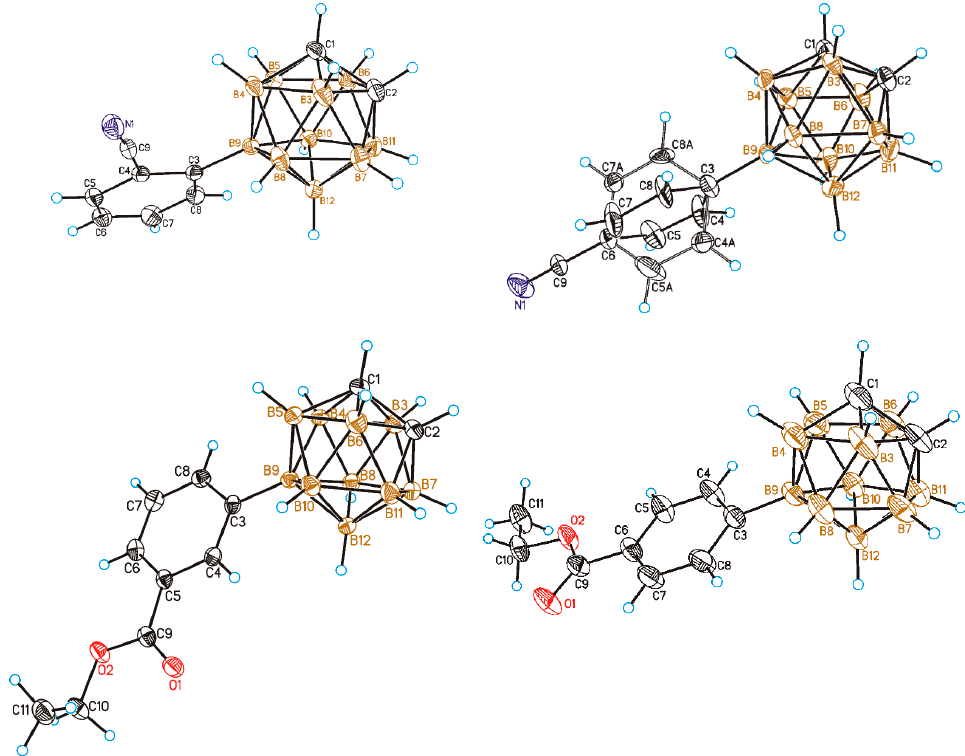
Figure 3. General views of 9-( o -NCC 6 H 4 )-1,2-C 2 B 10 H 11 ( 7 , top left), 9-( p -NCC 6 H 4 )-1,2-C 2 B 10 H 11 ( 8 , top right), 9-( m -EtOOCC 6 H 4 )-1,2-C 2 B 10 H 11 ( 10 , bottom left), and 9-( p -EtOOCC 6 H 4 )-1,2-C 2 B 10 H 11 ( 11 , bottom right) showing atomic numbering. Thermal ellipsoids are drawn at 50% probability level.